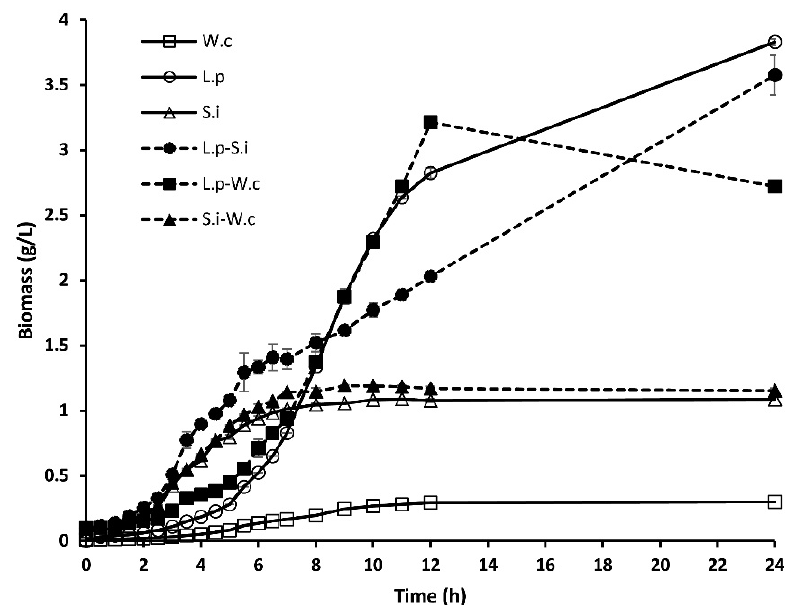
Figure 1. Biomass concentration during fermentation of MRS-starch broth at 30 °C using pure and mixed cultures of L. plantarum A6 (new name Lactiplantibacillus plantarum ), Sii 25124, and W. confusa A17. Results are means of three independent fermentations. W.c, W. confusa 17; L.p, L. plantarum A6; S.i, Sii 25124. Vertical lines show standard deviations.